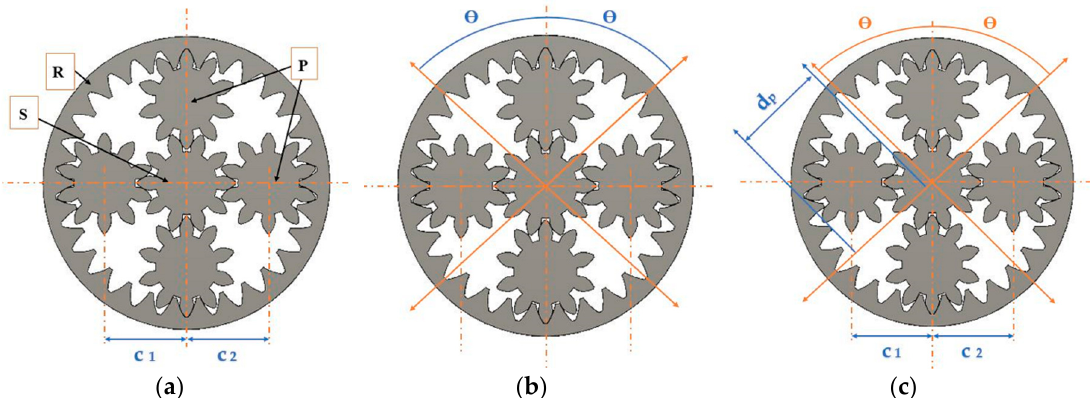
Figure 1. The three conditions for the relationship between gears in planetary gear selecting: ( a ) condition No. 1, ( b ) condition No. 2 and ( c ) condition No. 3 [56].